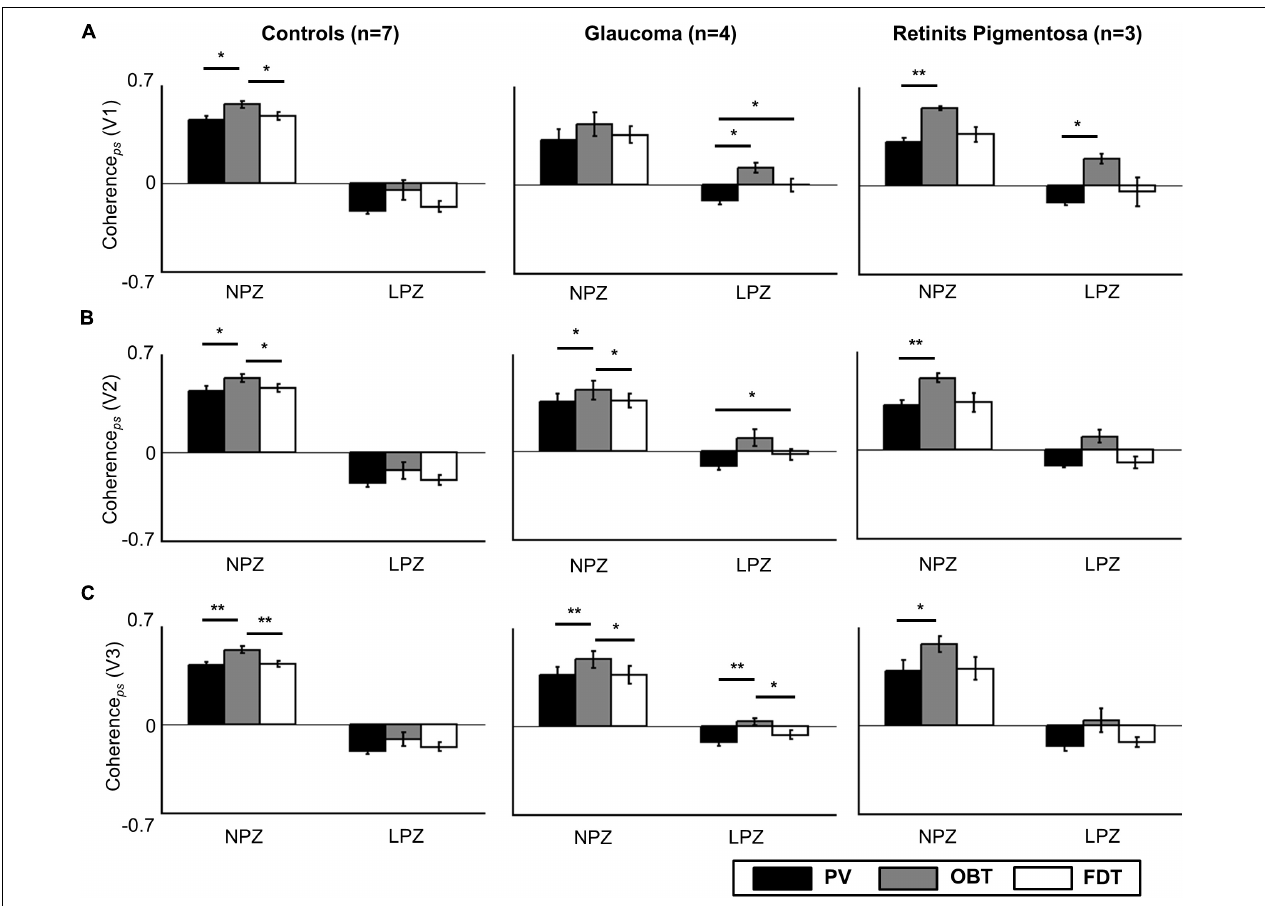
FIGURE 2 | Task dependence of coherence ps in V1 (A) , V2 (B) , and V3 (C) for the control ( n = 7), glaucoma ( n = 4), and retinitis pigmentosa groups ( n = 3; mean ± SEM). Controls and patients differ specifically for LPZ. Only in the patient groups’ LPZ, negative coherence ps during PV is shifted to positive values for OBT. Significance tests (corrected paired t -tests) on task effects were performed for all the participant groups, * p < 0.05 and ** p < 0.01. PV, passive viewing; OBT, one-back task; FDT, fixation-dot